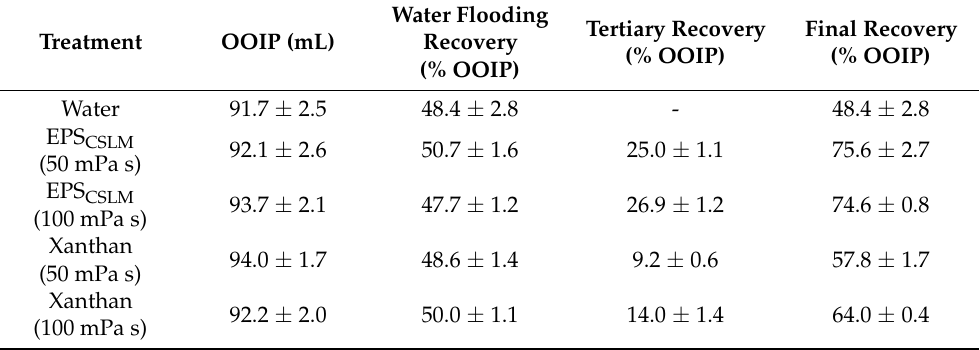
Table 5. Results of sand-pack column assays performed with the exopolysaccharide produced by Rhizobium viscosum CECT908 grown in the low-cost medium (EPS CSLM ) and xanthan gum. The apparent viscosity was measured at 40 ◦ C and the values presented correspond to a shear rate of 9.2 s − 1 . The results represent the average of three independent experiments ± standard deviation. Water Flooding Tertiary Recovery Treatment OOIP (mL) Recovery (% (% OOIP)